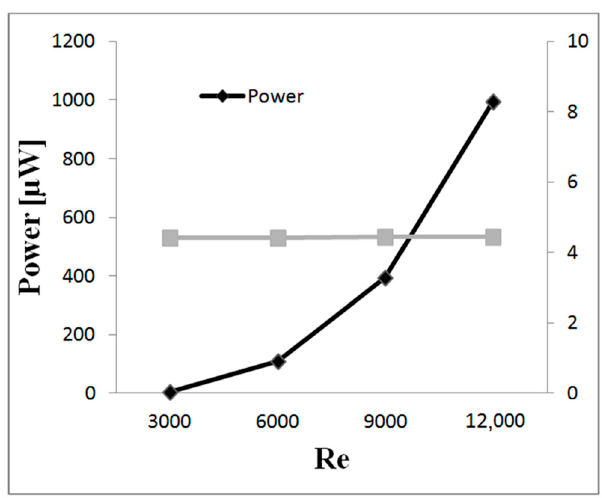
Figure 11. Power output of the energy harvester and the optimal k p for each Reynolds number.